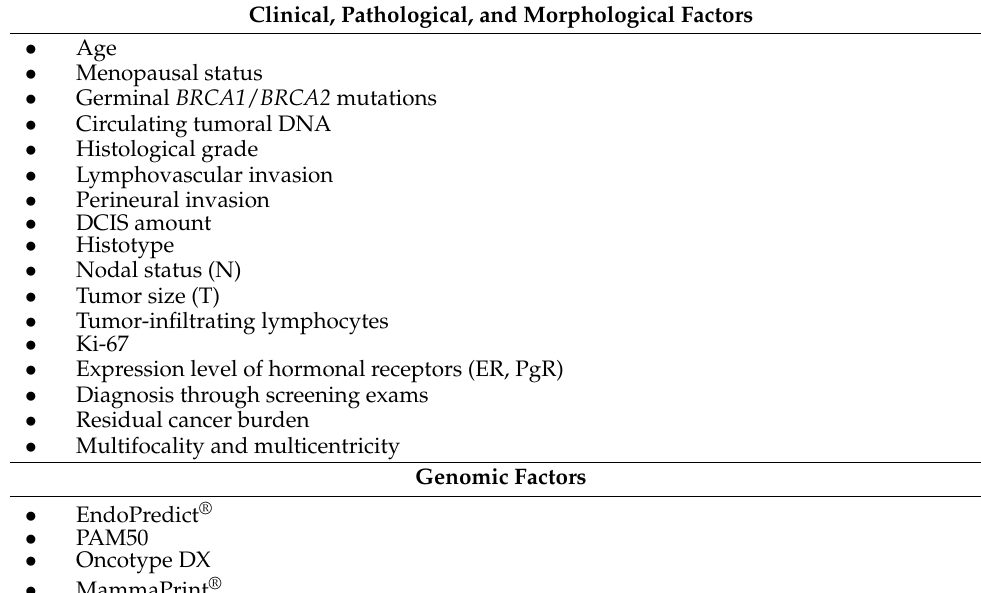
Table 1. Preliminary list of prognostic factors prognostic of for disease